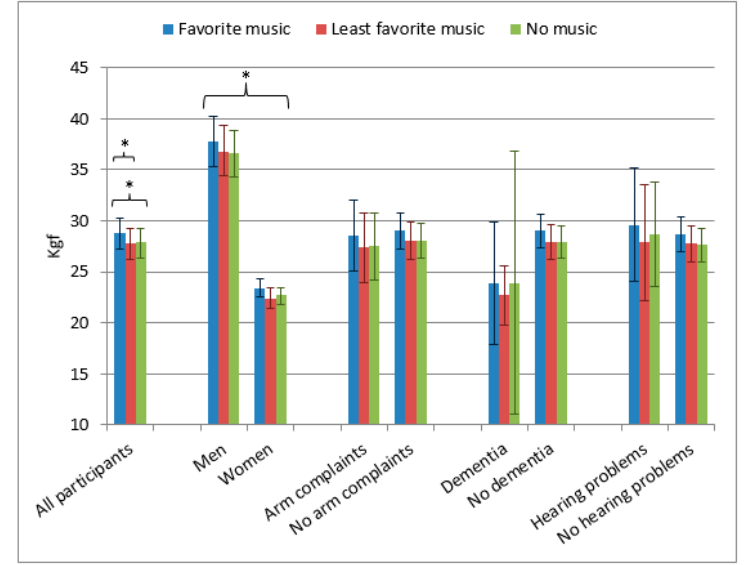
Figure 2. Mean handgrip strength in kgf (95% CI) related to type of music. * Significant differences (for favorite vs. least favorite music; favorite vs. no music; and men vs. women in all music categories).